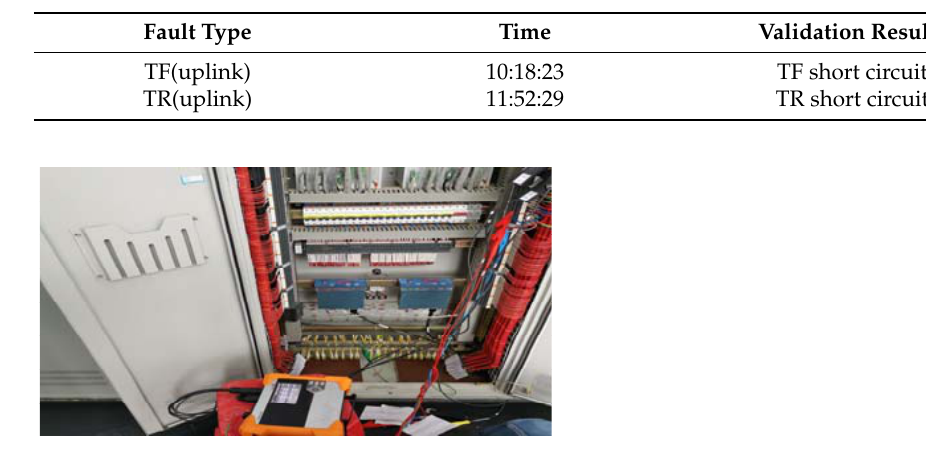
Table 5. Test and verification results of traction substation of Wuhan Guangzhou high-speed railway.